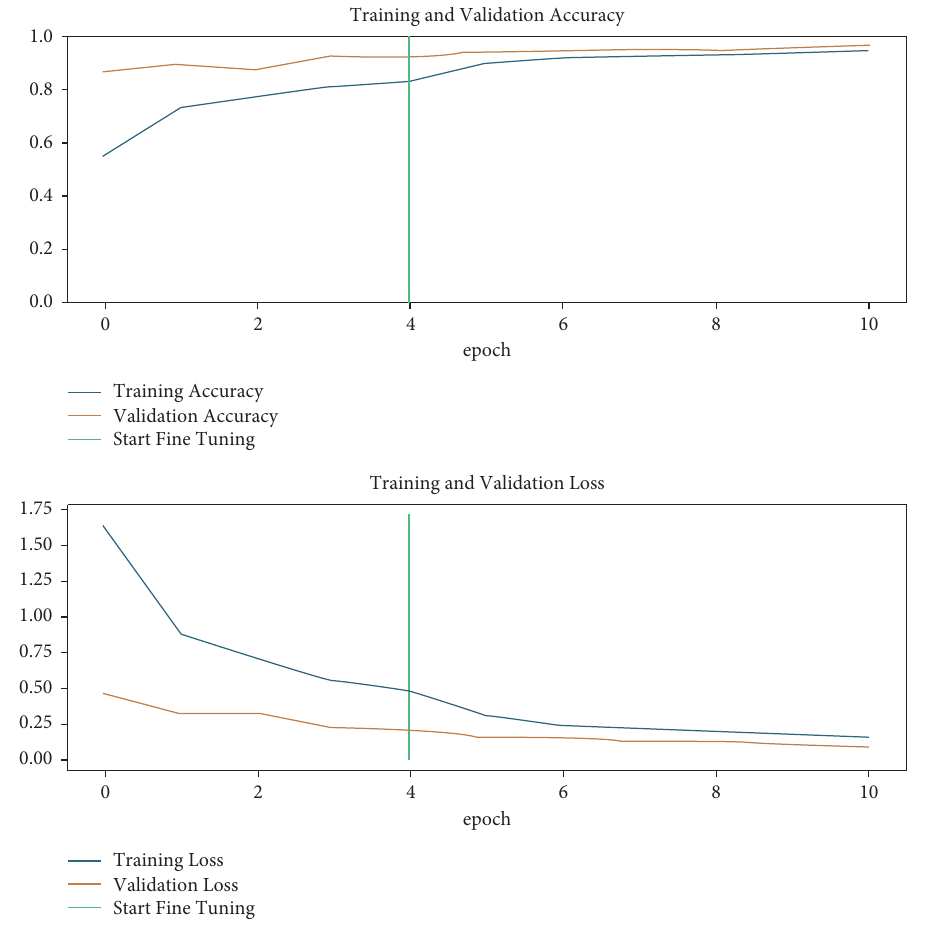
Figure 11: Training accuracy and loss graph.